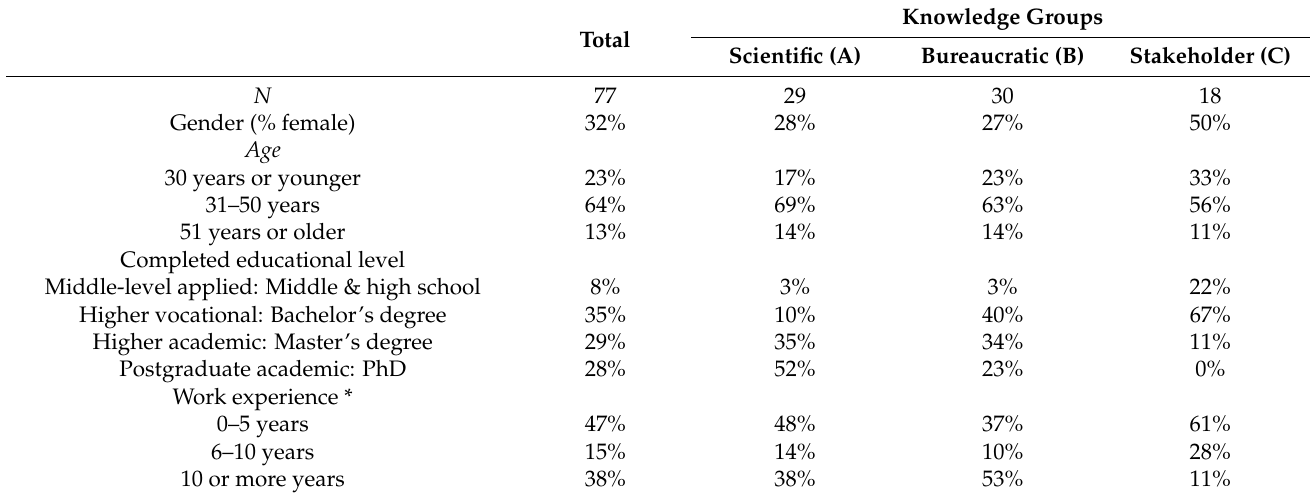
Table 1. Characteristics of